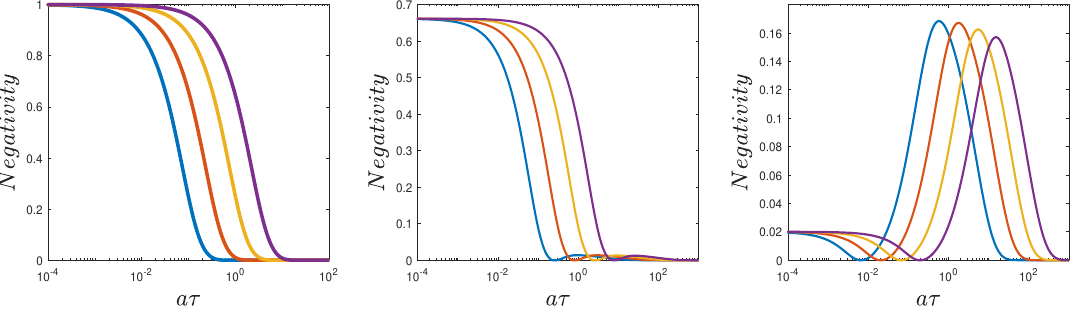
Figure 9 . Entanglement evolutionary process over time for different initial entangled states. The three subfigures stand for α = 1 /